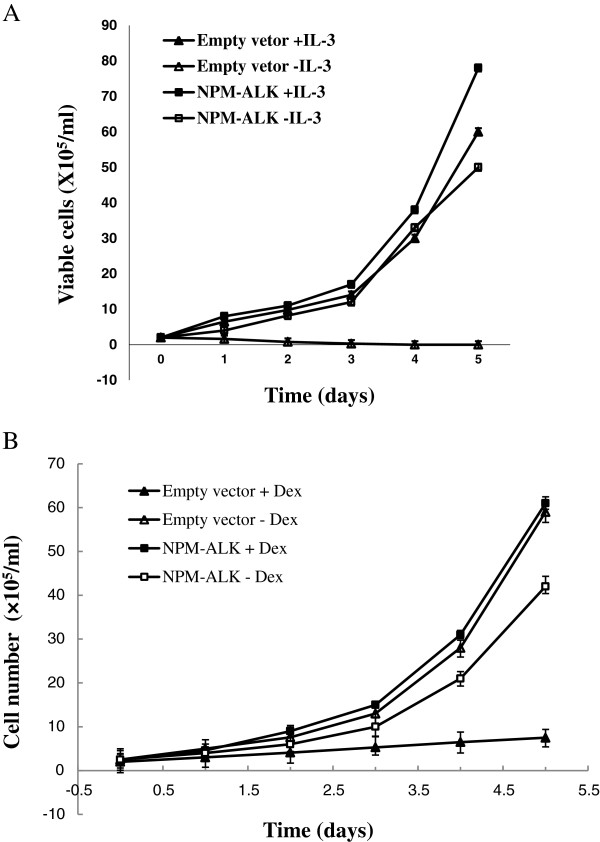
Overexpression of NPM-ALK in BaF3 cells induced their cytokine independent growth and resistance to dexamethasone treatment. (A) NPM-ALK confers IL-3-independent growth to BaF3 cells. Stably transfected BaF3 cells expressing NPM-ALK were assessed for growth in the presence or absence of IL-3, together with empty vector-containing cells. Viable cell counts were performed in triplicate using trypan blue at 24-hour intervals, with each point being the average of the triplicate measurements. (B) BaF3 cells transformed by NPM-ALK became resistant to GCs and could survive well in 1 μM Dex, while BaF3 cells transfected with empty vector could not proliferate at this concentration.